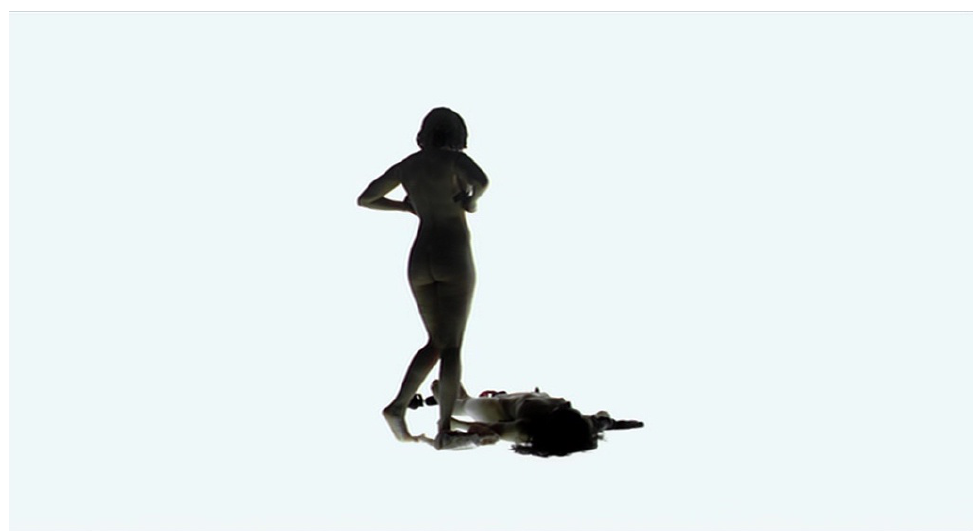
Figure 4: Under the Skin directed by Jonathan Glazer. 2013; London: BFI & Film 4.